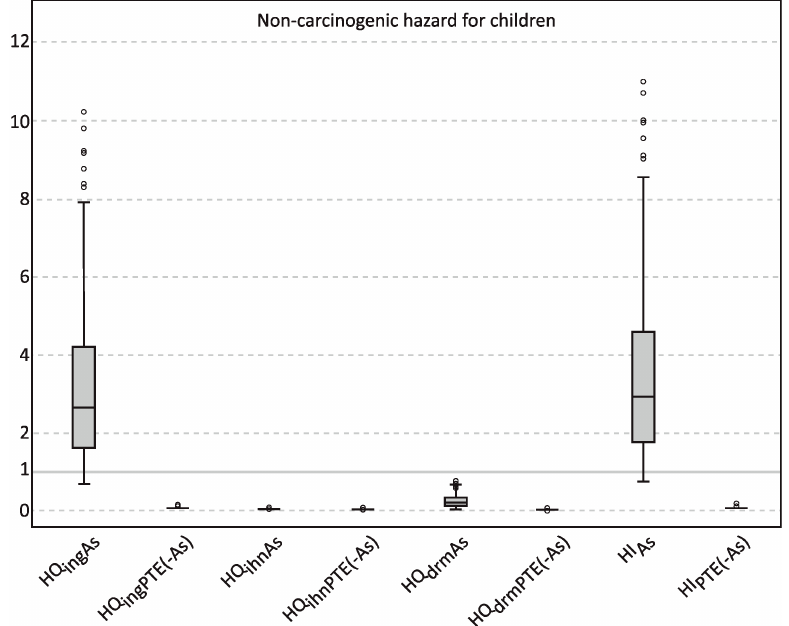
Figure 7. Comparative boxplot distribution of the Non-carcinogenic Hazard Quotient for children of As for Ingestion ( HQ ingAs ), Inhalation ( HQ ihnAs ), Dermal contact ( HQ drmAs ) routes, the Cumulative Hazard Index ( HI As ) and the sum of the Non-carcinogenic Hazard Quotient of the other defined PTEs (Ag, Cd, Cu, W and Zn) for Ingestion ( HQ ingPTE(-As) ), Inhalation ( HQ ihnPTE(-As) ), Dermal contact ( HQ drmPTE(-As) ) routes and the Cumulative Hazard Index ( HI PTE(-As) ) for topsoil samples (tailing samples were removed) in the Panasqueira area. The extremes and outliers were